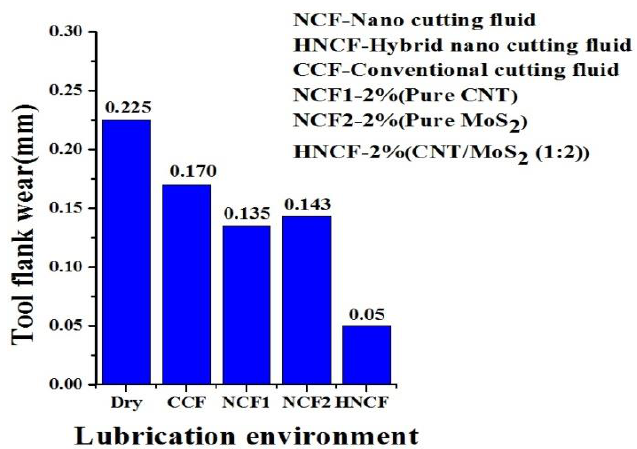
Figure 6. Variation of tool flank wear with different lubrication environment (CS=80 m/min, FR= 0.161 mm/rev and DOC =0.5